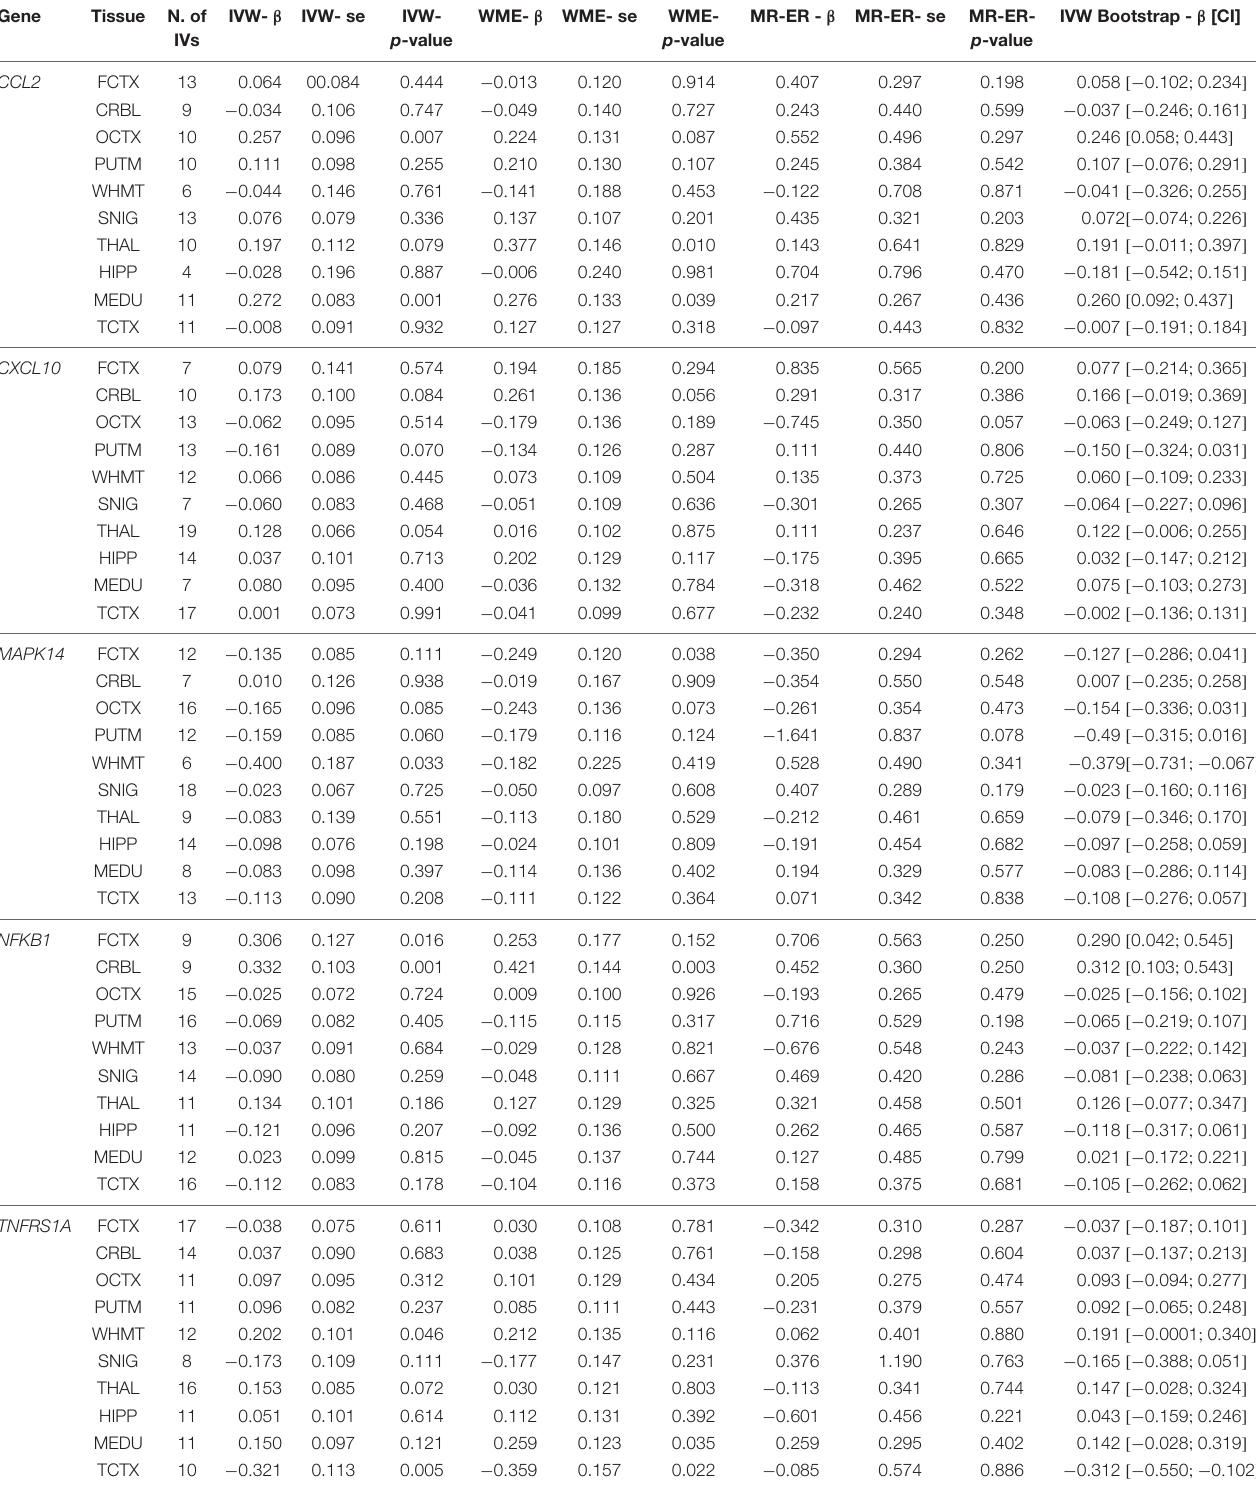
TABLE 2 | Result of Univariable MR